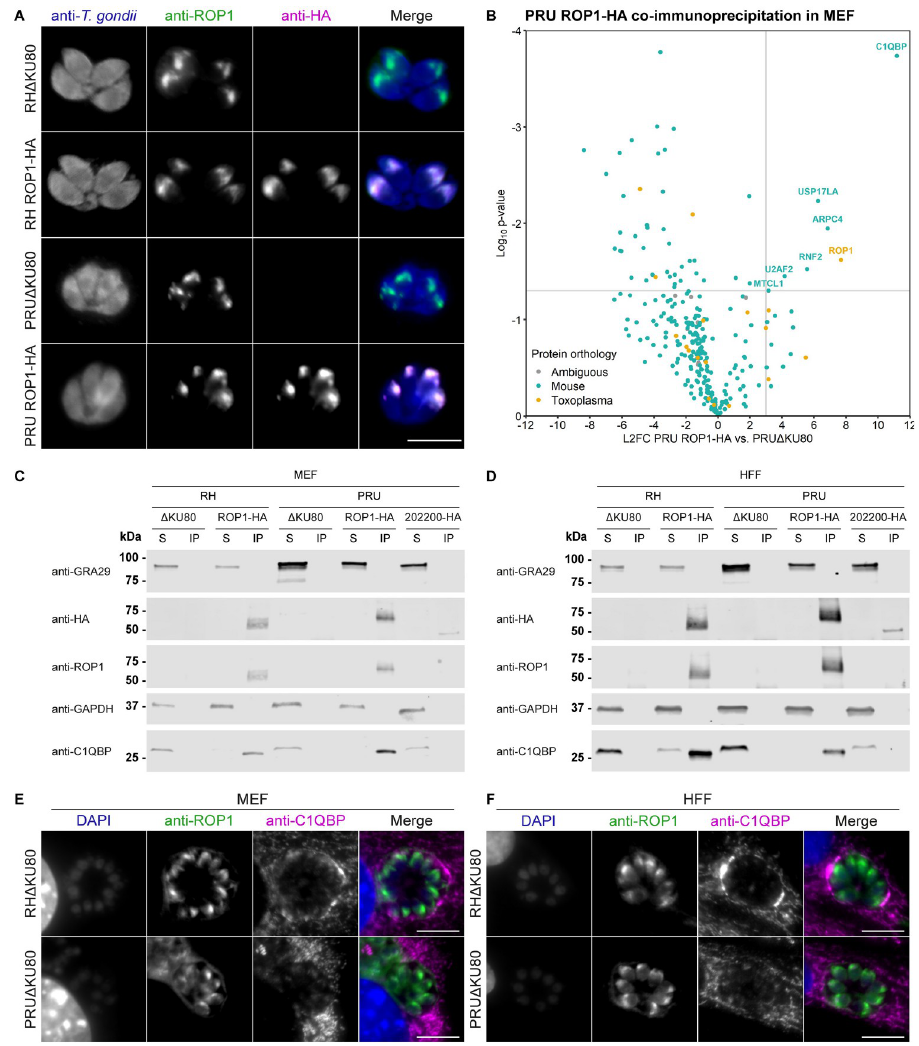
Fig 5. ROP1 co-immunoprecipitates with host C1QBP. A. Immunofluorescence verification of C-terminal HA- tagging of ROP1. Scale bar = 10 μ m. B. Enrichment of proteins that co-immunoprecipitate with ROP1. Primary MEFs were infected with PRU Δ KU80 or PRU ROP1-HA parasites for 24 h, following which ROP1 was immunoprecipitated with anti-HA agarose matrix and co-immunoprecipitated proteins were identified and quantified by mass spectrometry. L2FCs were calculated from the geometric mean of the iBAQ intensities across replicates, and p-values calculated by two-sided Welch’s t- test. Proteins with p-value < 0.05 and L2FC > 3 are annotated. C, D. Co- immunoprecipitation of C1QBP with ROP1 in C primary MEFs and D HFFs infected with RH ROP1-HA, PRU ROP1-HA, and PRU 202200-HA. S = post-immunoprecipitation supernatant, IP = immunoprecipitate. Note that the immunoprecipitate fraction represents 3x the relative amount of the total lysate compared to the post-IP supernatant fraction. E, F. Immunofluorescence localisation of ROP1 and C1QBP in RH Δ KU80 and PRU Δ KU80 infected E primary MEFs and F HFFs at 24 hours post-infection. Scale bar = 10 μ